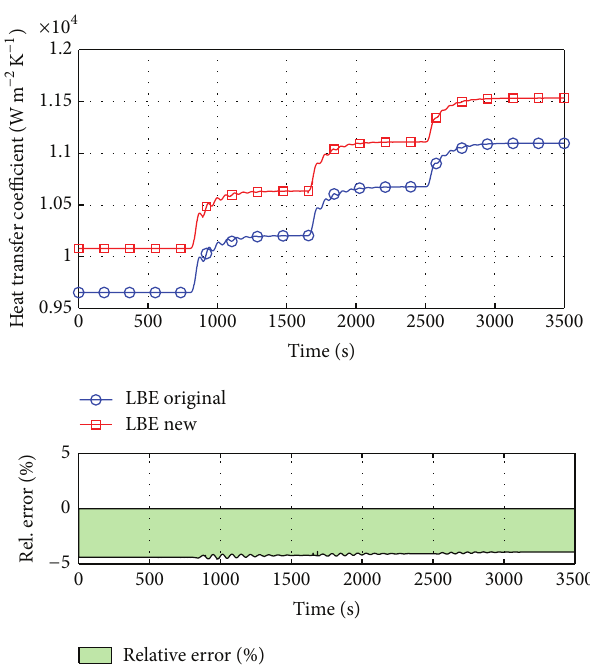
Figure 26: LBE heat exchanger heat transfer coefficient, original versus new “tpf” file.